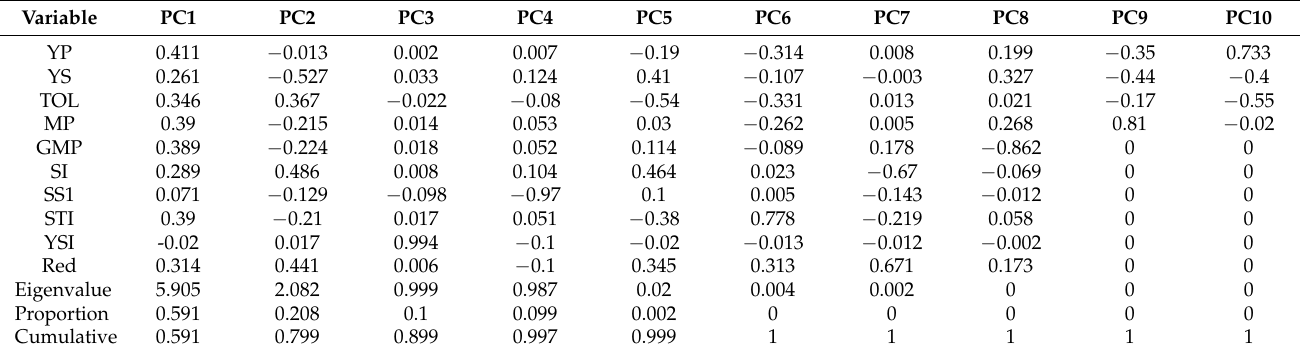
Table 13. PCA of yield under well-watered (YP), yield under water-stressed (YS) and drought tolerance indices.